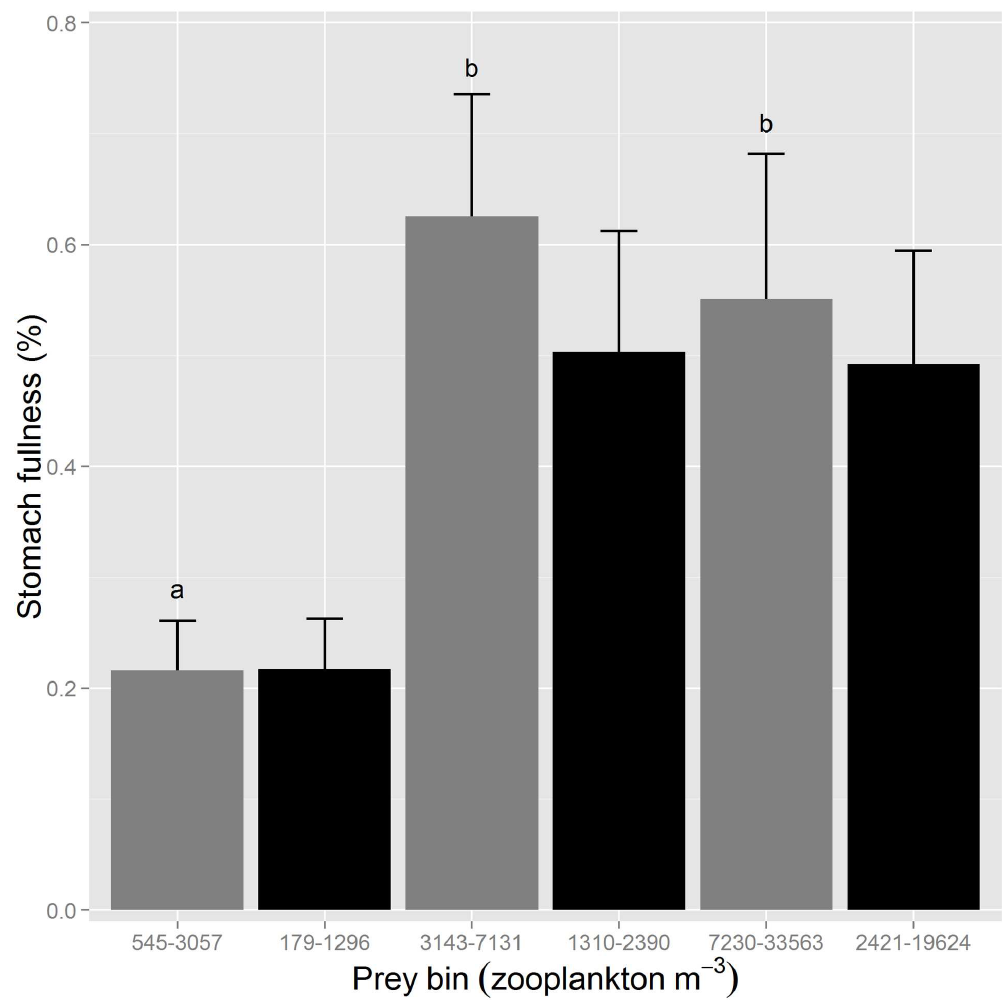
Fig 5. Mean stomach fullness for wild Delta Smelt by mesozooplankton density. Grey bars represent freshwater ( < 0.55psu) and black bars represent brackish habitat ( (cid:21) 0.55 psu). Bins of low, medium, and high mesozooplankton abundance were definedby the rank of mesozooplanktonabundance of each tow, 15 tows per bin in freshwater, and 15–16 tows per bin in brackish habitat. The number of fish that fell in each bin, in order of increasing mesozooplankton abundance,is 58, 76 and 83 in freshwater and 54, 48 and 50 in brackish. Note that we only tested for differences in means within freshwater or brackish habitat and that the x-axis is not continuousor to scale. Differingletters indicatestatistically significantdifferences (there was no significantdifference betweenthe three brackish habitat means). Error bars are SEs.